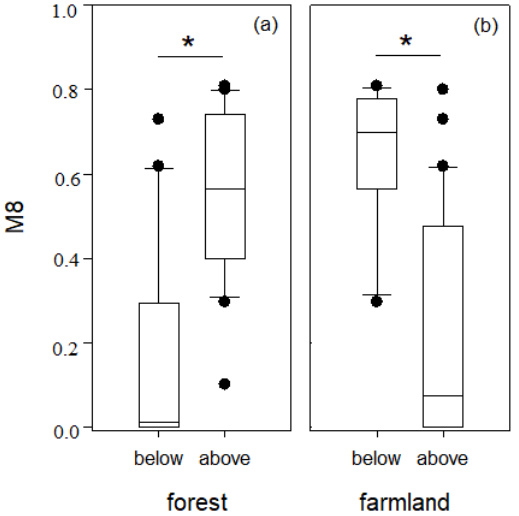
Figure5. BoxplotsofM8(proportionofsensitivespecies)forthesitesbelowandabovetheenvironmental change point of forest cover ( a ) and farmland cover ( b ) (* represents a significant di ff erence as derived by the Mann-Whitney non-parameter test. The horizontal line in each box represents the median value. Solid points indicate extreme abnormal